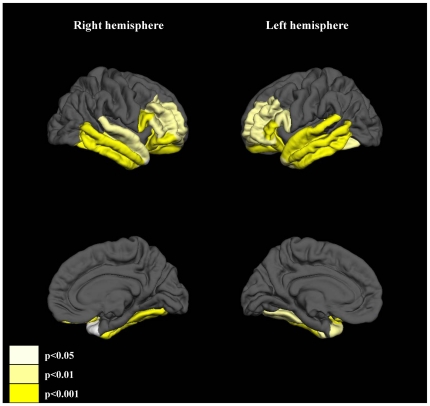
Significant cortical thinning of ROIs in schizophrenia patients compared with that of healthy subjects observed in this study.ROIs were differentially colored according to the p values of the post hoc tests.